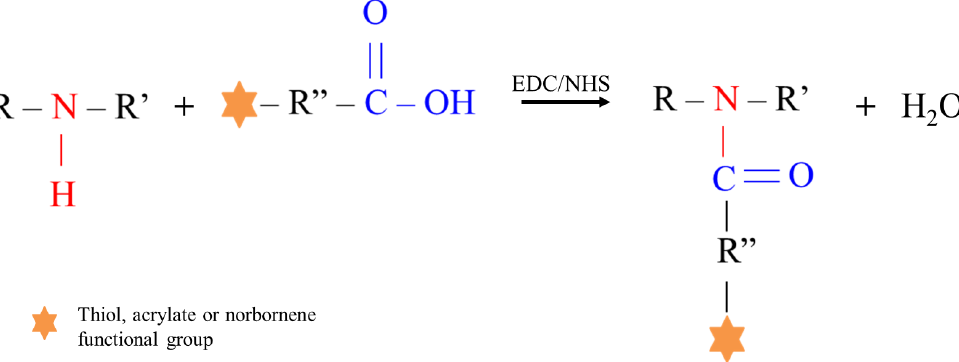
Figure 2. Schematic representation of carbodiimide-mediated tertiary amide bond formation between secondary amines and carboxylic acid groups exposed along the PEU and grafting molecule chains, respectively. The orange star stands for the exposed functional groups (i.e., thiols, acrylates or norbornene moieties).